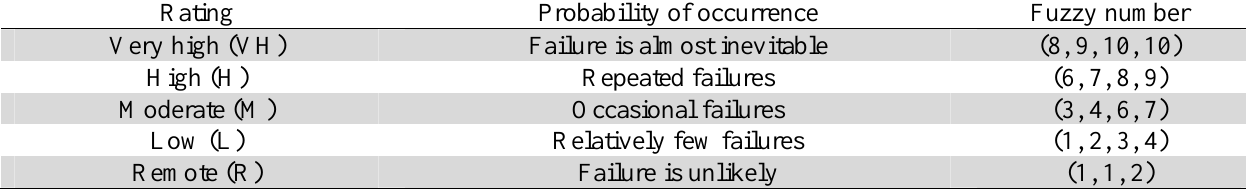
Fuzzy ratings for occurrence of a failure (Chin et al., 2008; Wang et al., 2009)